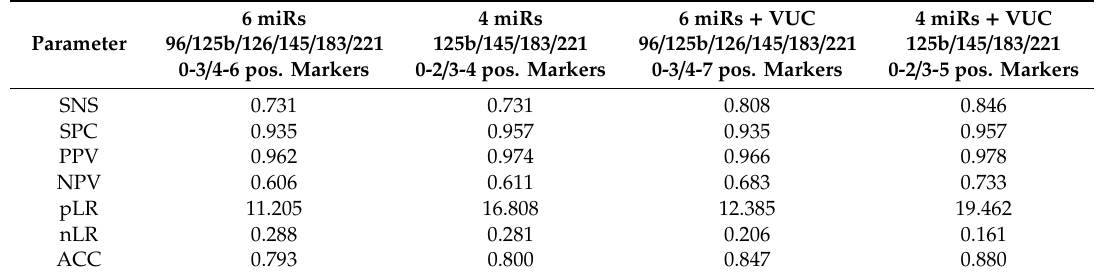
Table 5. Diagnostic performance of combinations of selected miRNAs with each other and with VUC.